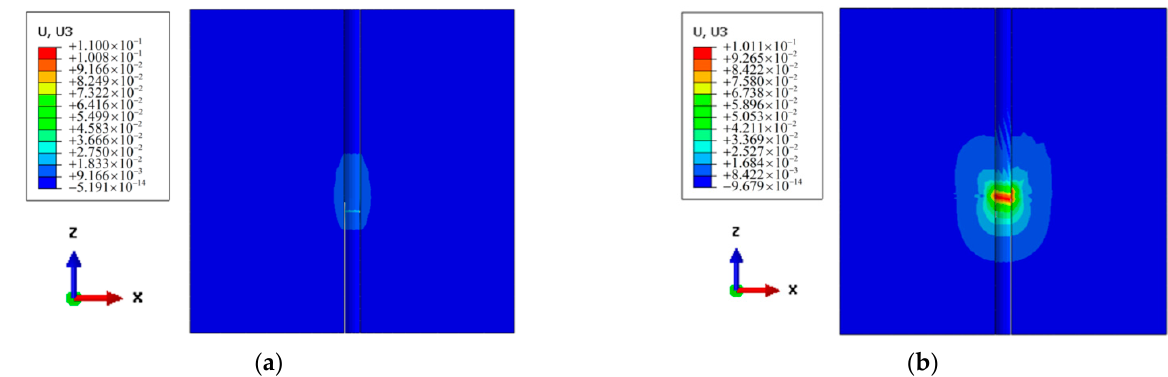
Figure 10. Displacement nephograms of soil around the piles. ( a ) Monopile; ( b ) Helical pile.